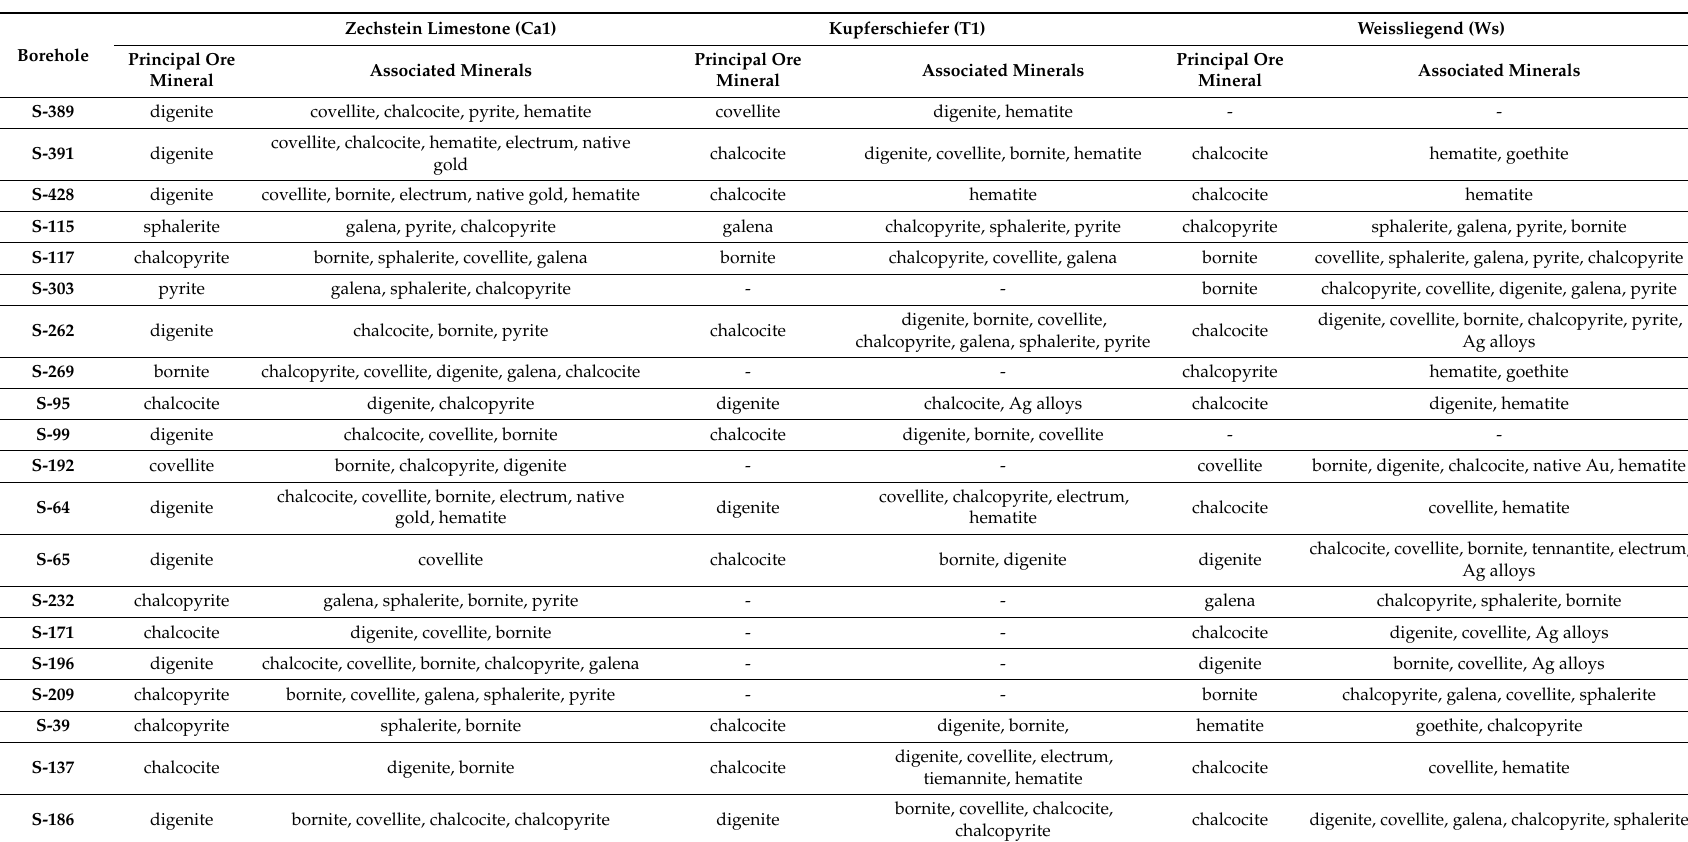
Table A1. Ore Minerals Recognized Microscopically in Studied Boreholes from the Cu-Ag Kupferschiefer Deposits on the Fore-Sudetic Monocline in Poland.